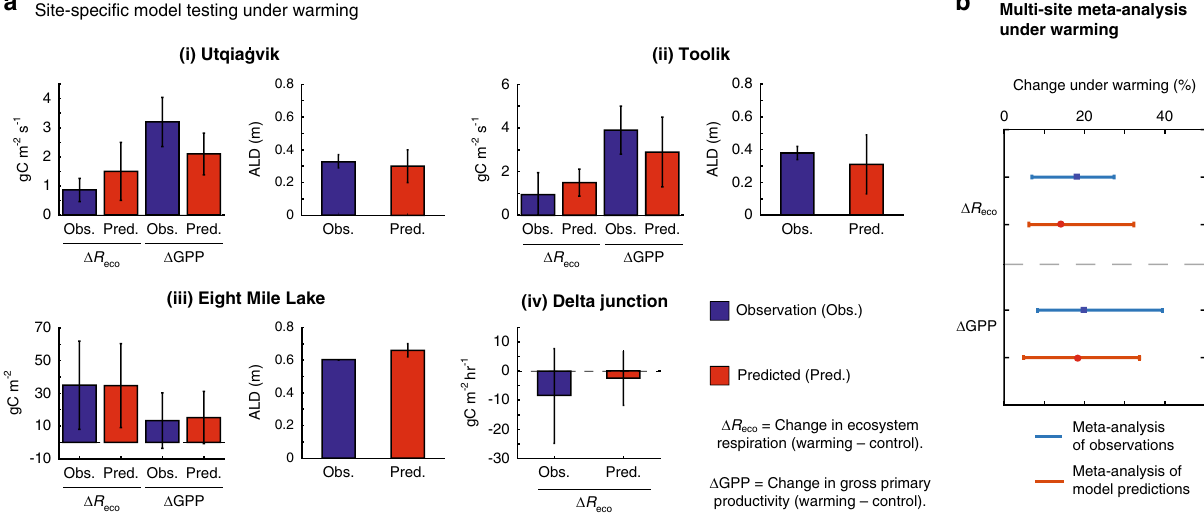
Δ GPP = Change in gross primary productivity (warming – control). Fig. 1 Model-data comparisons demonstrate ecosys accurately represents ecosystem responses to short-term warming. a Site-speci fi c comparisons between observations and ecosys predictions for (i) Utqia ġ vik, (ii) Toolik, (iii) Eight Mile Lake, and (iv) Delta Junction. The model output was collected over the same time period as that of the experimental perturbation and observations. Experimental data were taken from refs. 7,9,26,60,75 (see Table 1), while active layer depth was aggregated from the circumpolar active layer monitoring network (https://www2.gwu.edu/~calm/) for Utqia ġ vik and Toolik, and compiled from measurements at Eight Mile Lake. The change in ecosystem respiration ( Δ R eco ) and gross primary productivity ( Δ GPP) represent the difference between warming and the ambient control experiments. These data were extracted from the experimental publications. The active layer depth is a direct comparison between measurements and simulations. Each bar shows the interannual mean of each metric, and the error bars represent the standard deviation around the mean. Two-way analysis of variance tests indicated no signi fi cant differences between observed and modeled perturbation responses. b Meta-analysis of model output compared with a recent meta-analysis of observations 27 of high-latitude response to warming at the four sites. This forest plot shows the % divergence from the control studies for both observations (in blue), and the modeled response (in red). Each bar depicts the mean (solid square), and the variance (standard deviation) around the mean. A one-way anova found no signi fi cant differences between the % divergence between the model output and the empirical data.